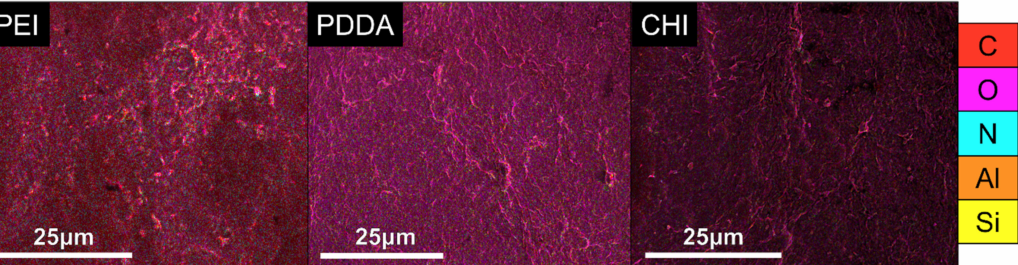
Figure 3. EDX maps of PEI, PDDA and CHI coatings where carbon, oxygen, nitrogen, aluminium and silicon are represented by C, O, N, Al and Si, respectively.